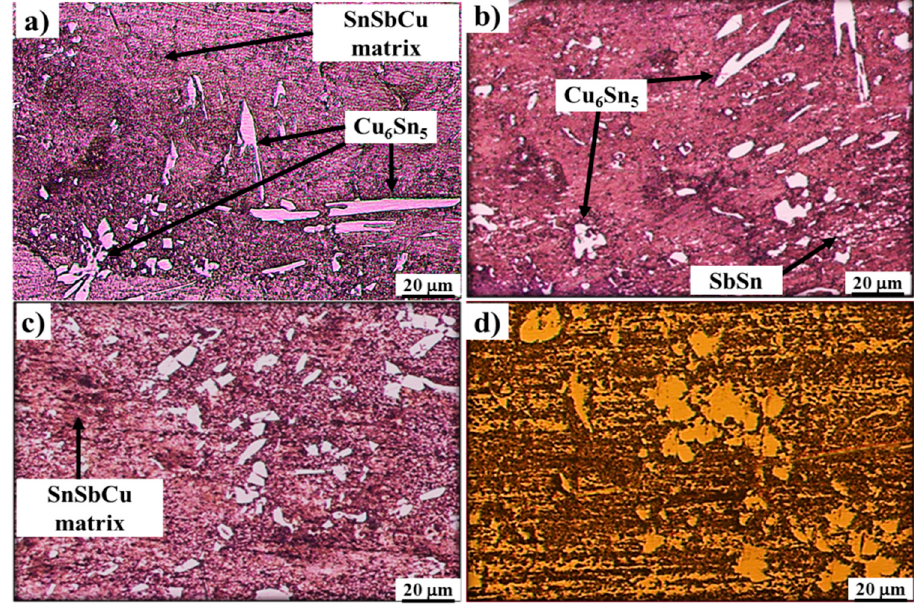
Figure 5. Microstructures of ( a ) tin-based Babbitt alloy, and tin-based Babbitt nanocomposites containing ( b ) 0.25 wt%, ( c ) 0.50 wt%, and ( d ) 1.0 wt% alumina nanoparticles correspondingly.